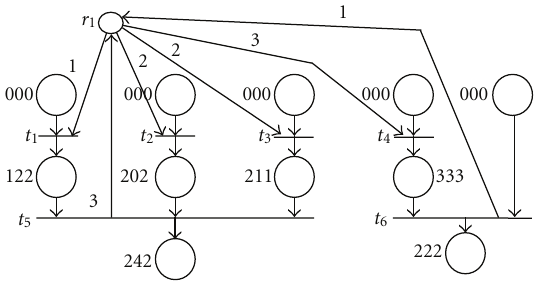
Figure 2: Token flow relation for resource